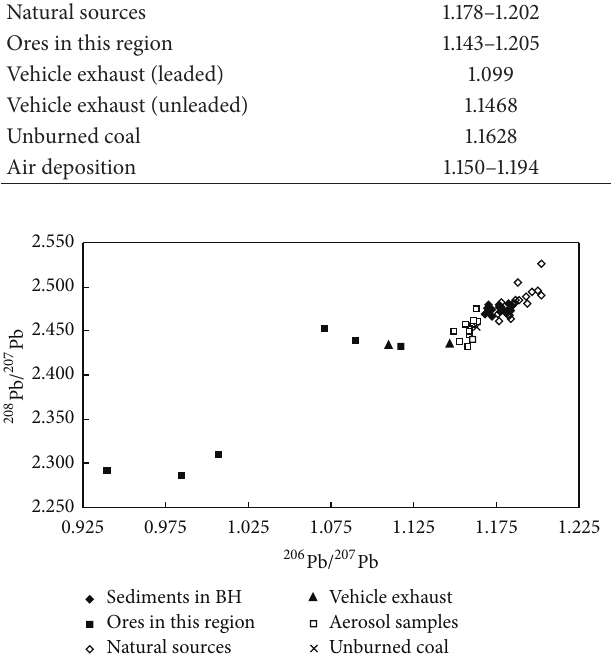
Figure 3: Comparison of the Pb isotopic ratios in sediments of Bohai Bay and other